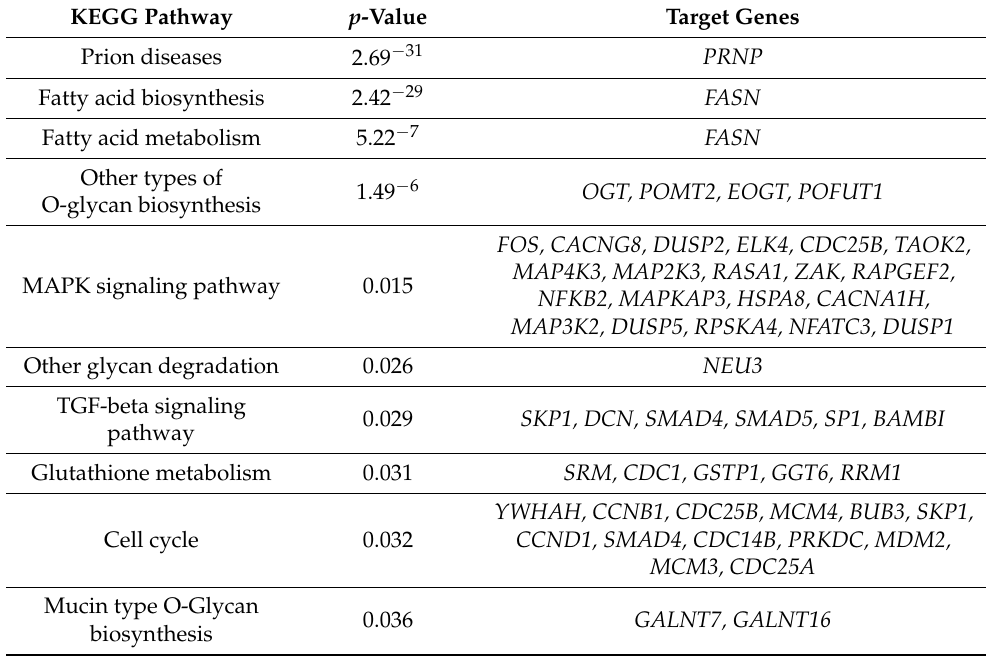
Table 2. KEGG pathways significantly altered by